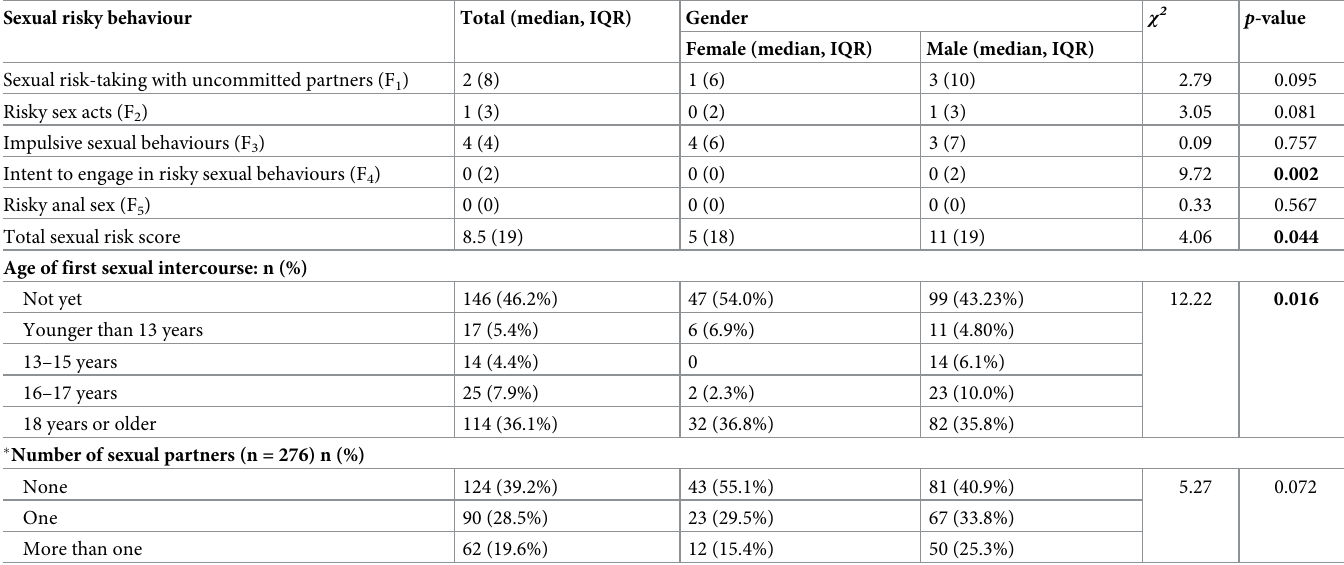
Table 2. Gender differences in sexual risk-taking and